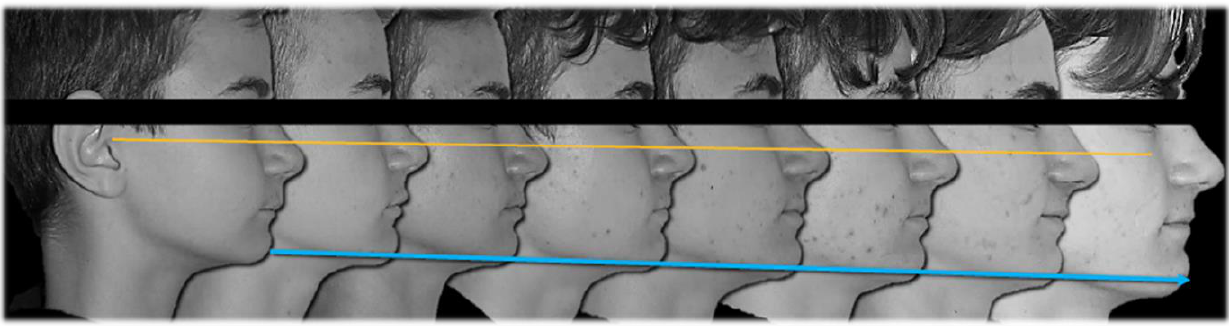
Figure 5. Aesthetic